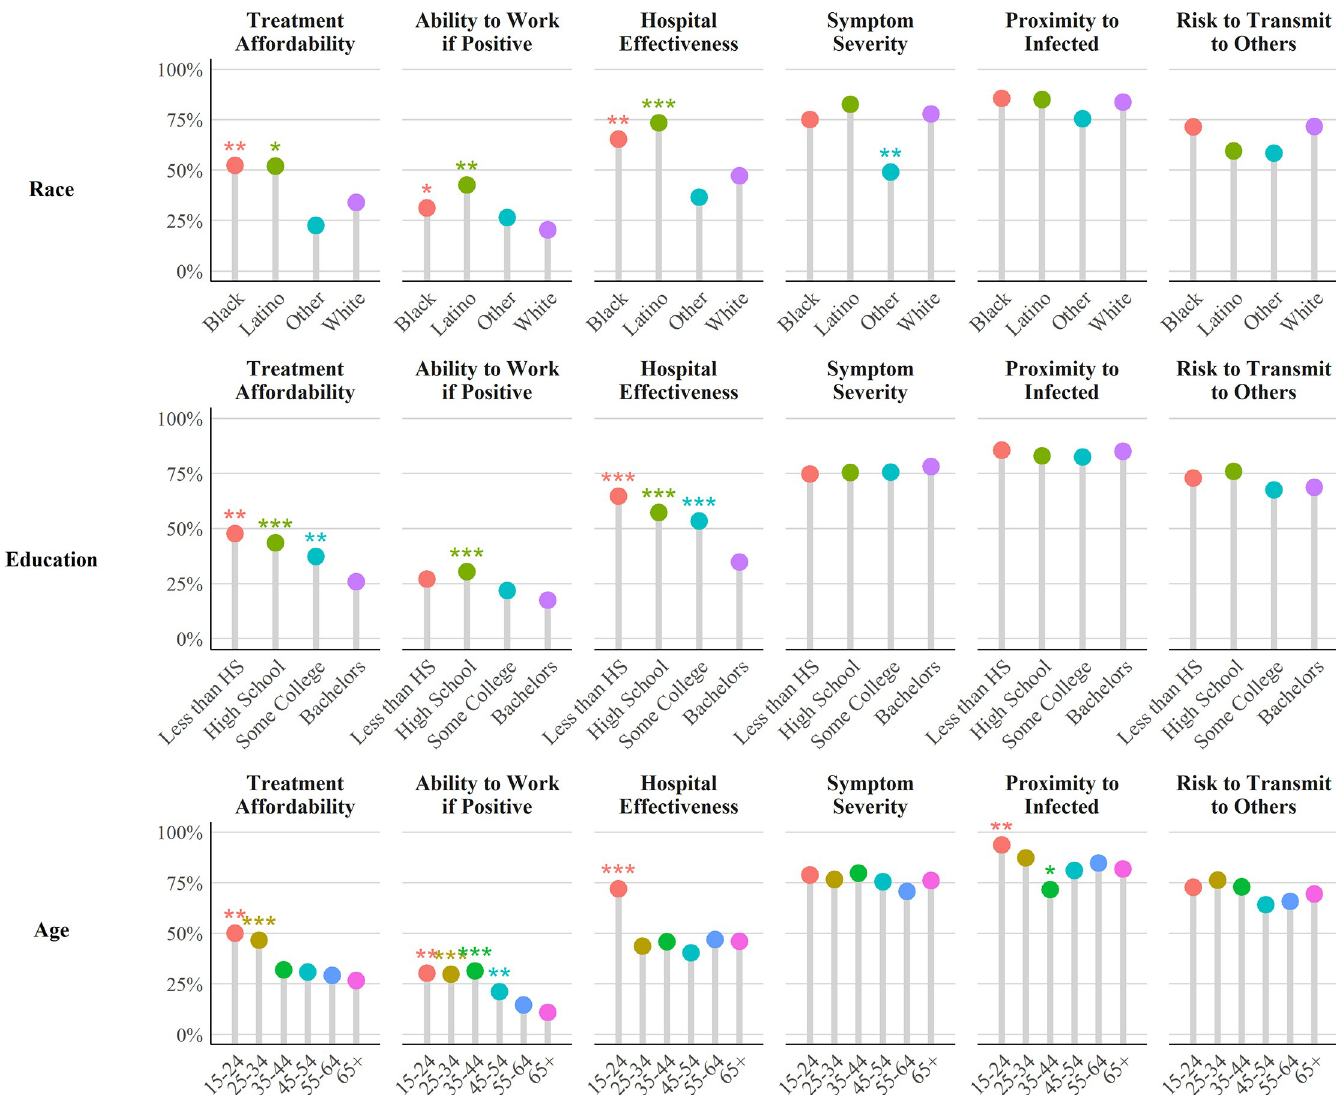
Fig 1. Factors associated with anticipated testing for COVID-19 by race, education, and